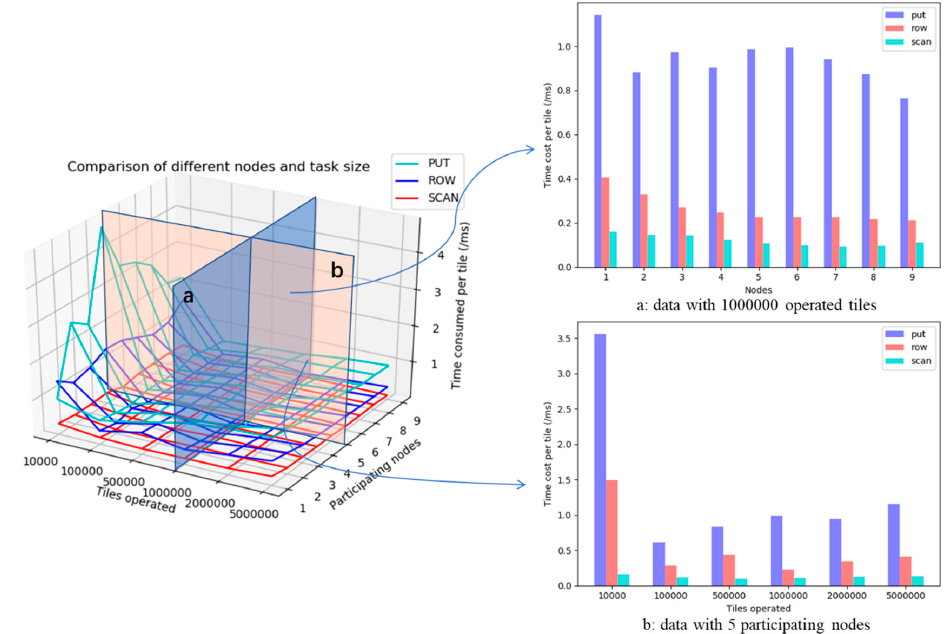
Figure 8. Time cost per tile under different nodes and workloads for PUT, ROW, and SCAN. ( a ) results with 10 6 operated tiles; ( b ) results with 5 participating nodes